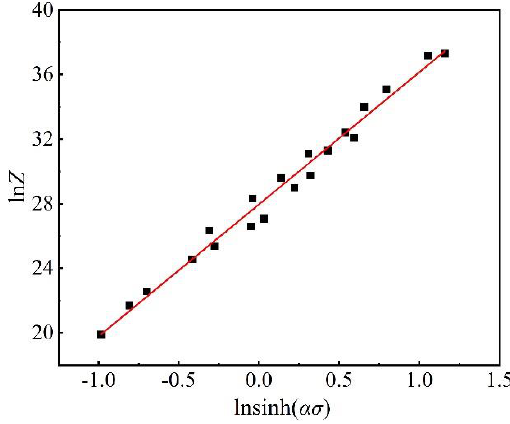
Figure 5. Relationship between ln Z and ln [ sinh ( ασ )] .